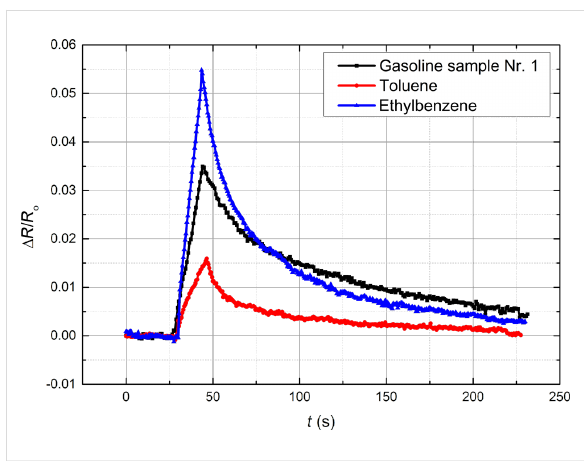
Figure 8: Relative change of the electrical resistance of EVA–CB (7.75 phr CB) as a function of time in different vapours after exposure for 15 s (0.0037 mL/L). The sample thickness is 50